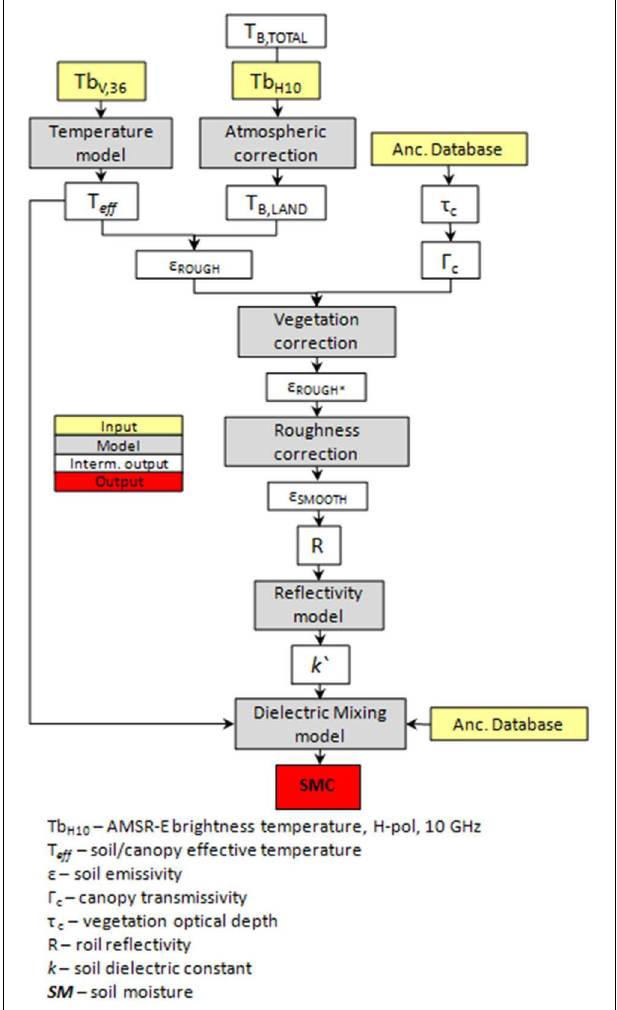
FIGURE 2 | Schematic representation of the Single Channel Algorithm (SCA). SCA is based on an inverse solution of the radiative transfer model. It requires limited amount of ancillary data. The algorithm is run using X-band AMSR-E